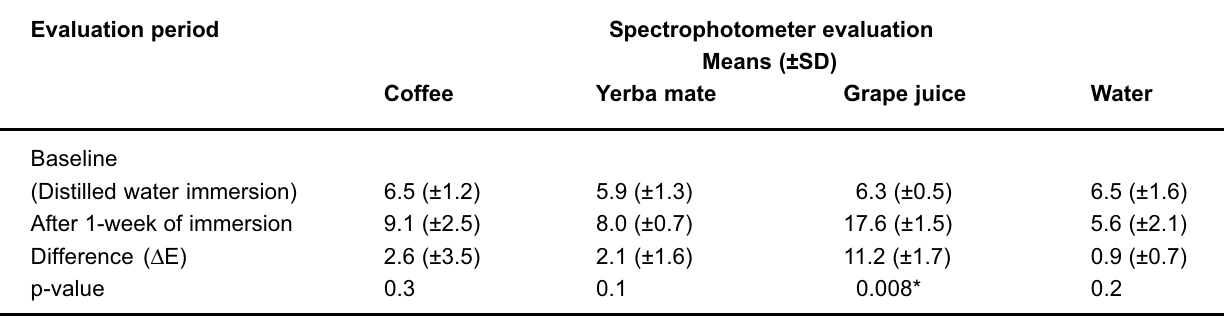
* Difference statistically significant between groups (p<